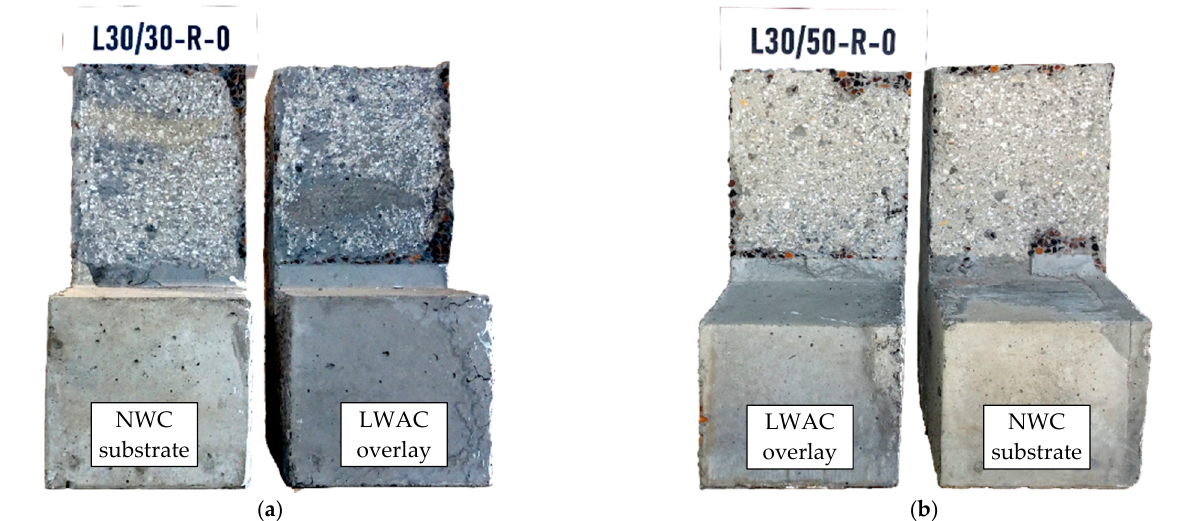
Figure 15. View of the test specimens with rough interface after failure: ( a ) L30/30-R-0, ( b ) L30/50-R-0.